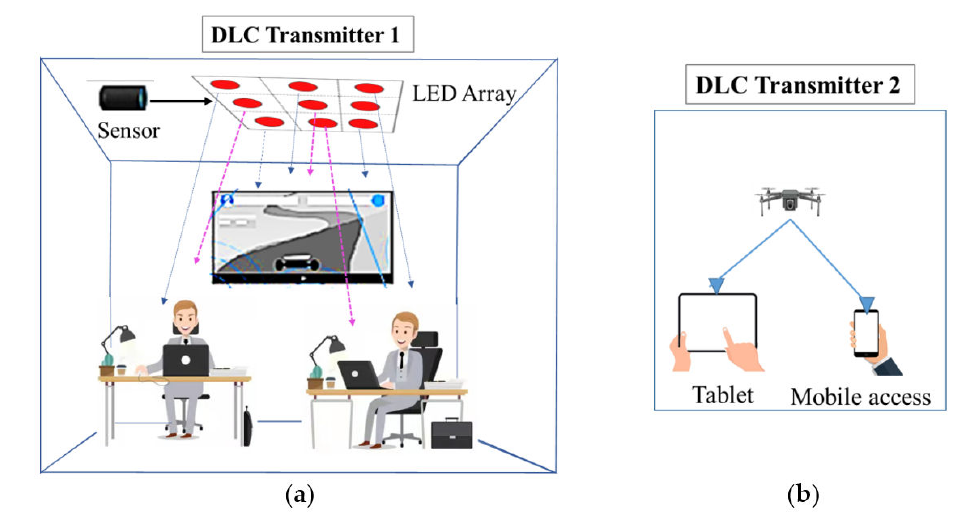
Figure 12. DLC potential applications. ( a ) LED array transmission; ( b ) drone transmission.